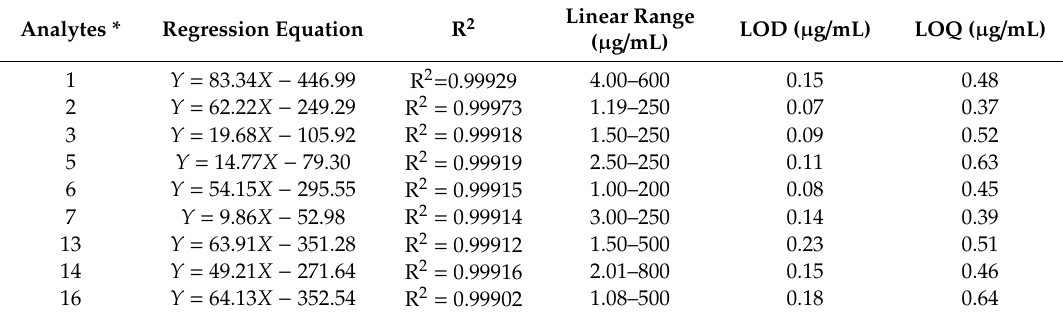
Table 5. Calibration curve data for nine reference compounds ( n = 3).